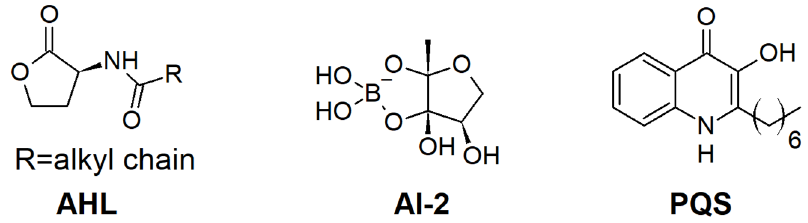
Figure 1. Examples of signaling molecules that mediate quorum sensing.